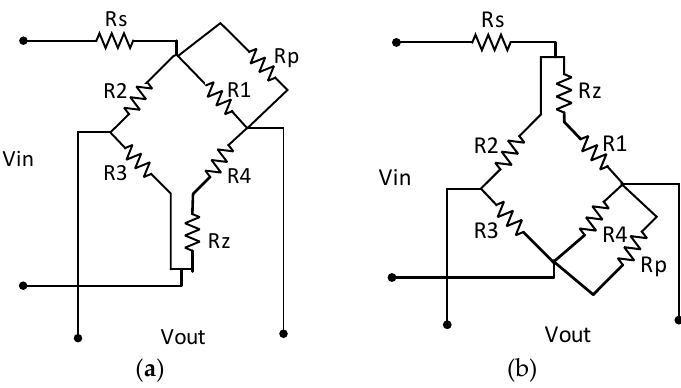
Figure 5. Passive resistor temperature compensation model with a constant voltage supply: (a ) negative initial offset voltage; ( b ) positive initial offset voltage.